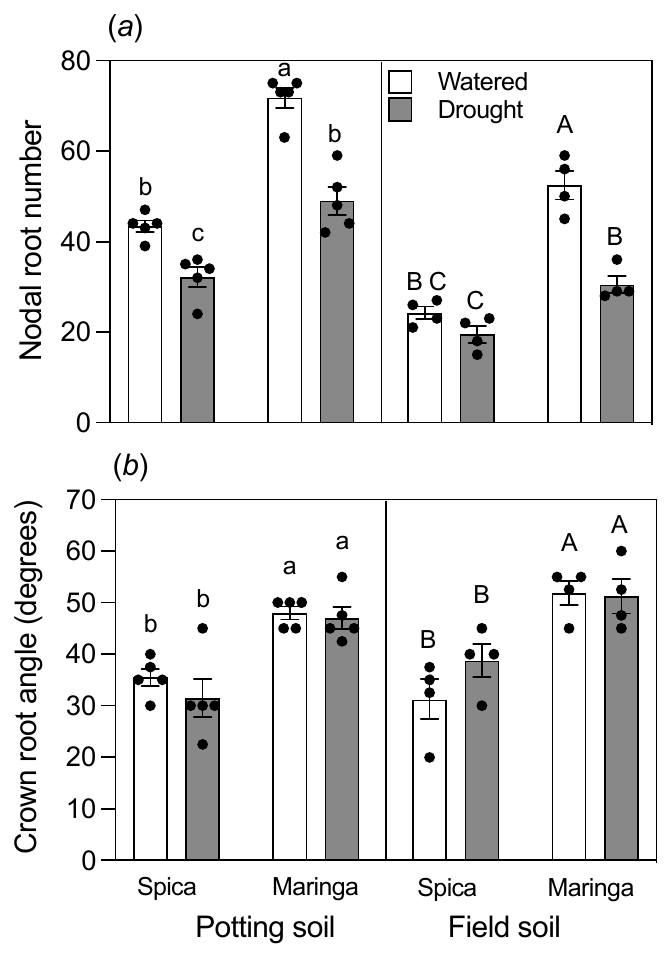
Figure 5. Differences in numbers of nodal roots and crown root angles between Spica and Maringa are robust to soil type and water treatments. Numbers of nodal roots ( a ) and angles of root crowns ( b ) of the two genotypes in watered (empty bars) and drought (filled bars) treatments after 28 d of growth. Individual values are shown as circles, and error bars represent ± SE of the mean for either five replicates (potting soil) or four replicates (field soil). Data for potting and field soils were analyzed separately by two-way ANOVAs. Different lowercase letters reflect significant differences between treatments as determined with the Tukey test at p < 0.05 for potting soil, whereas different uppercase letters reflect significant differences between treatments at p < 0.05 for field soil. The interaction between water and cultivar factors for potting soil was ( a ) significant at p < 0.05 for nodal root number and ( b ) not significant for crown root angle. The interaction between water and cultivar factors for field soil was ( a ) significant at p < 0.05 for nodal root number and ( b ) not significant for crown root angle.